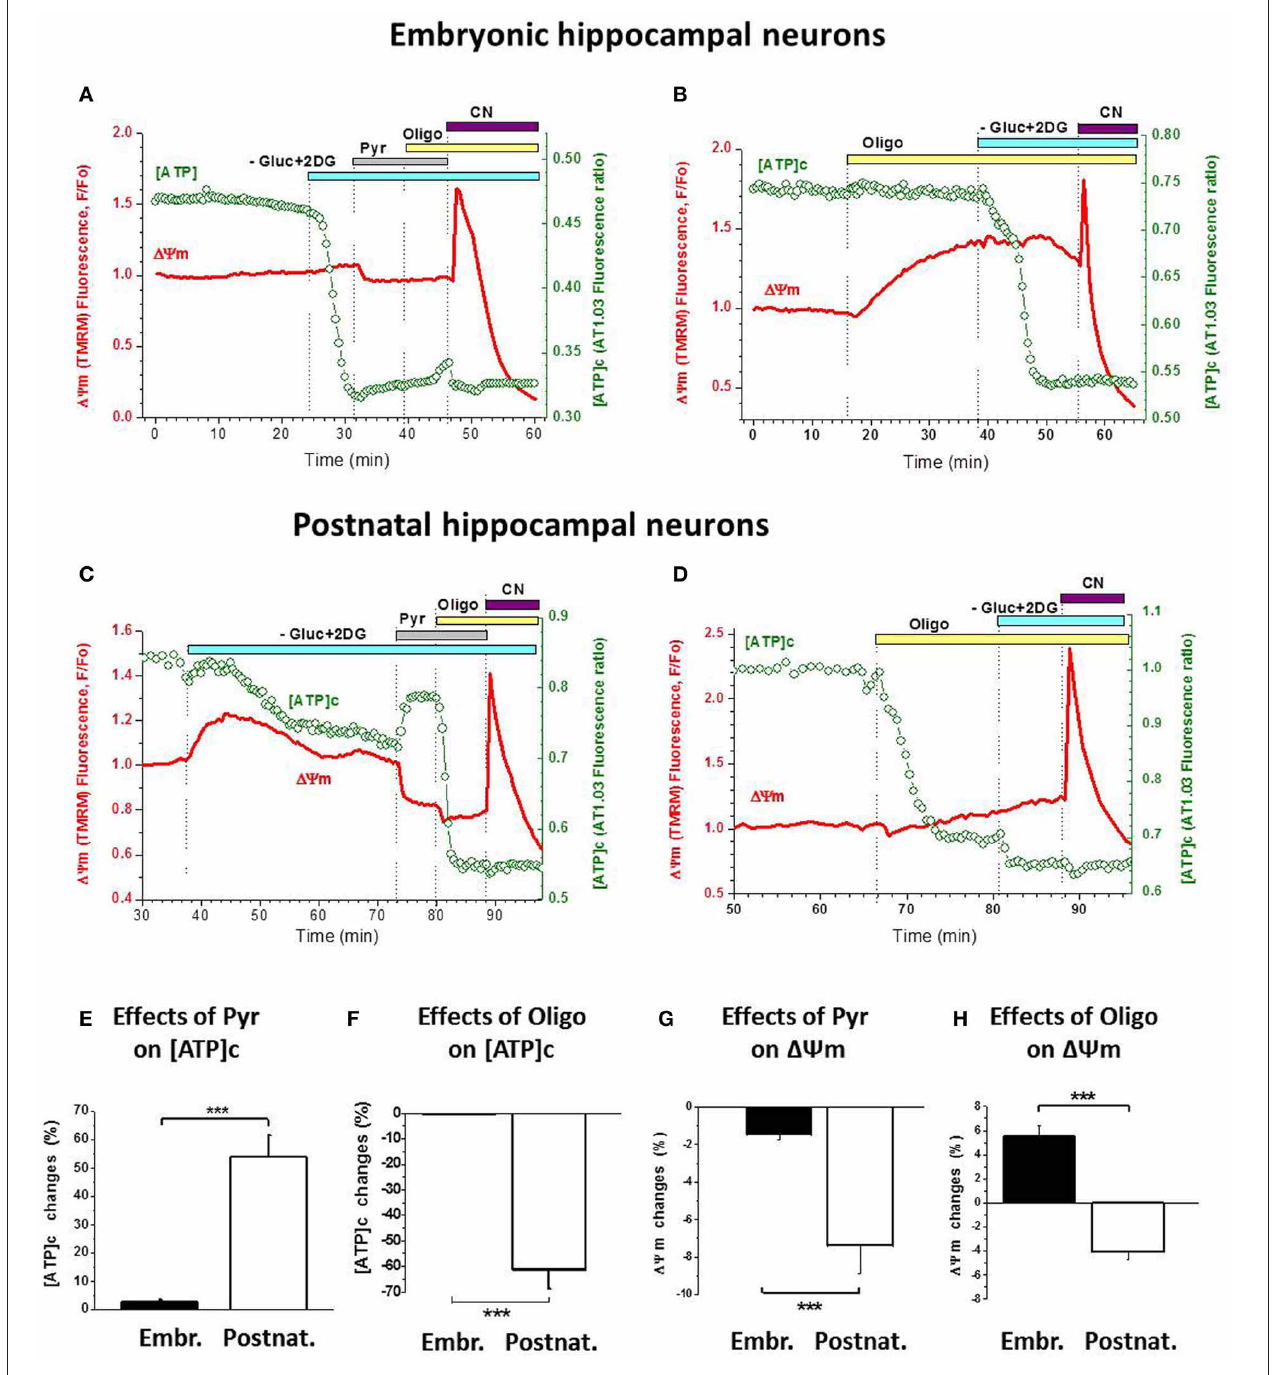
FIGURE 5 | Postnatal hippocampal cultured neurons, unlike the embryonic ones, have a functional ATP synthesis by F1Fo-ATPase. (A) Changes in [ATP]c (green trace, right axis) and (cid:2)(cid:3) m (red trace, left axis) induced in embryonic neurons by sequential application of Gluc-free buffer containing 2-DG (light-blue bar), 10mM Pyr (gray bar), 5 μ g/mL Oligo (yellow bar), and 3mM NaCN (purple bar). (B) Changes in the above parameters induced in embryonic neurons by application of 5 μ g/mL Oligo (yellow bar) followed by Gluc-free buffer containing 2-DG (light-blue bar), and 3mM NaCN application (purple bar). (C) Changes in the above